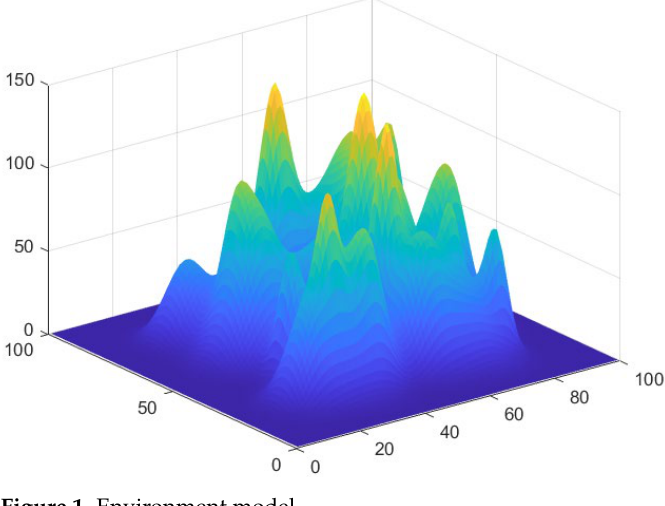
Figure 1. Environment model.